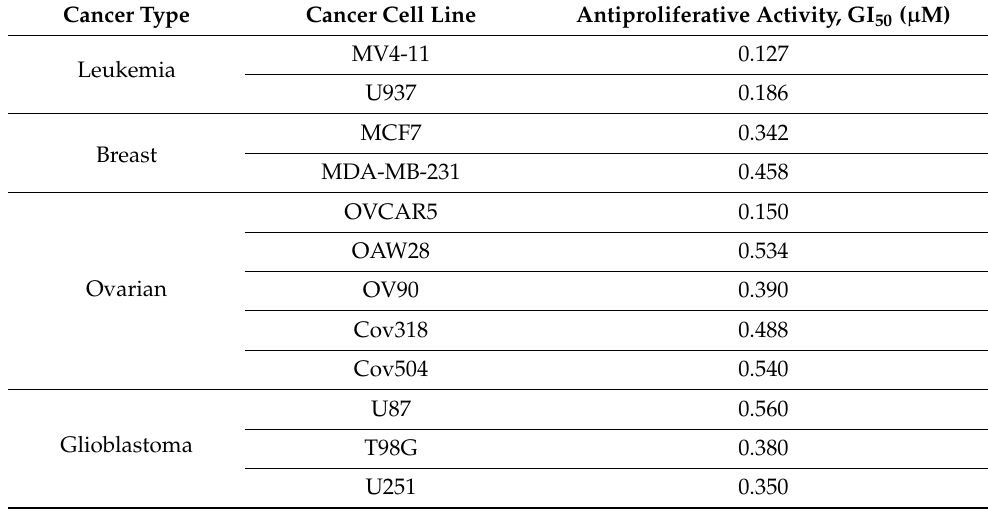
Table 4. Antiproliferative effects of 15